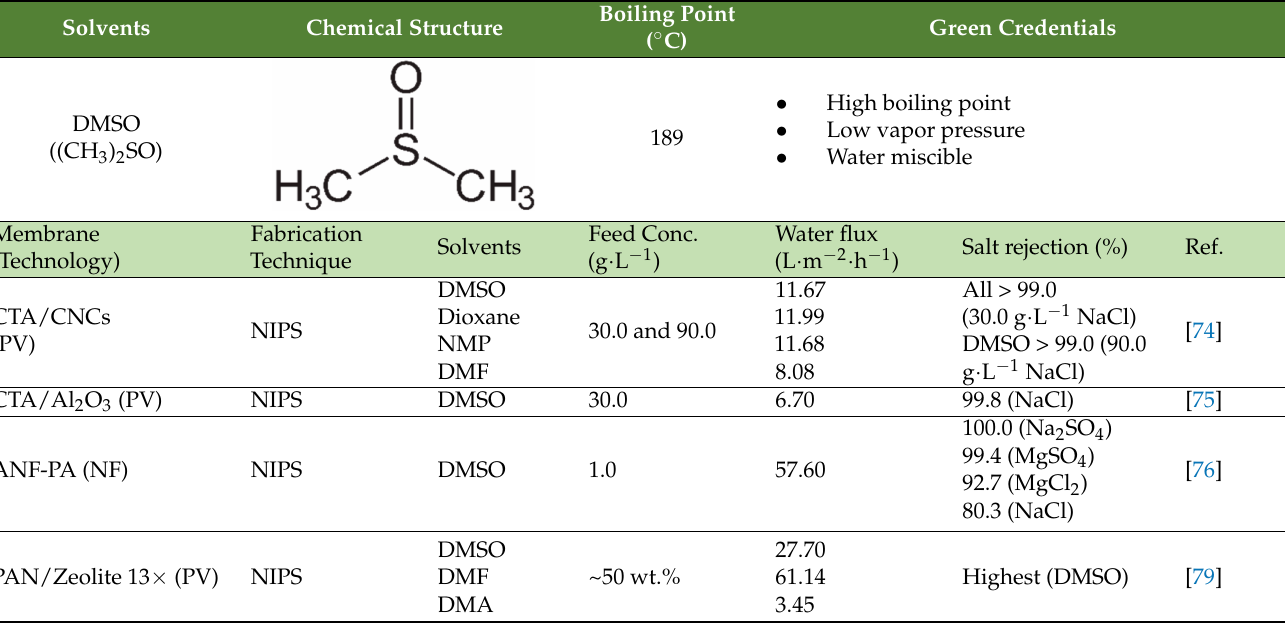
Table 3. Characteristics of synthetic organic solvents and their summarized studies in membrane desalination. Solvents Chemical